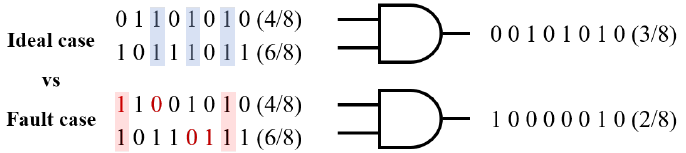
Figure 8. Comparison between ideal case and fault